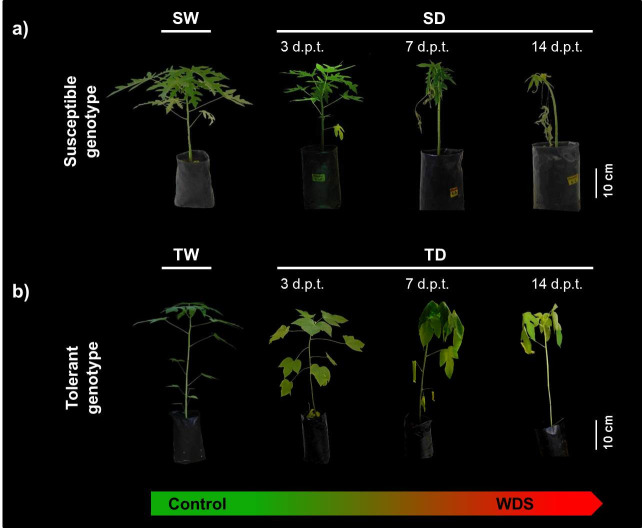
Morphological characterization of C. papaya plants under well-watered and WDS conditions.Representative photographs showing plants from the Susceptible (S) (a) and Tolerant (T) (b) genotypes, either well-watered (SW and TW), or during a 14 d.p.t. period of WDS (SD and TD). The time of stress exposure (from left to right; 3, 7 and 14 d.p.t. after water withholding) is indicated.